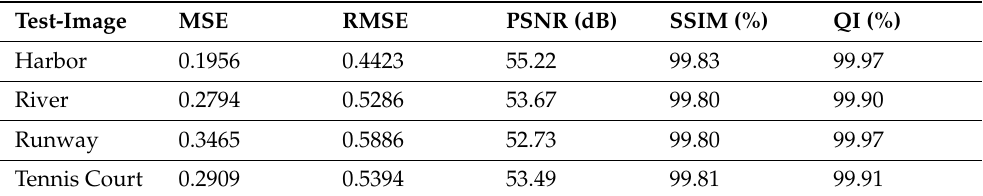
method achieved effectual performance under all the images. For example, with the harbor test image, the BSBE-PPODLC technique gained an MSE of 0.1956, RMSE of 0.4423, PSNR of 55.22 dB, SSIM of 99.83% and a QI of 99.97%. Meanwhile, with the river test image, the BSBE-PPODLC technique obtained an MSE of 0.2794, RMSE of 0.5286, PSNR of 53.67 dB, SSIM of 99.80% and a QI of 99.90%. Eventually, with the runway test image, the BSBE-PPODLC method reached an MSE of 0.3465, RMSE of 0.5886, PSNR of 52.73 dB, SSIM of 99.80% and a QI of 99.97%. Table 1. Overall encryption outcomes of the proposed BSBE-PPODLC approach under distinct test images.